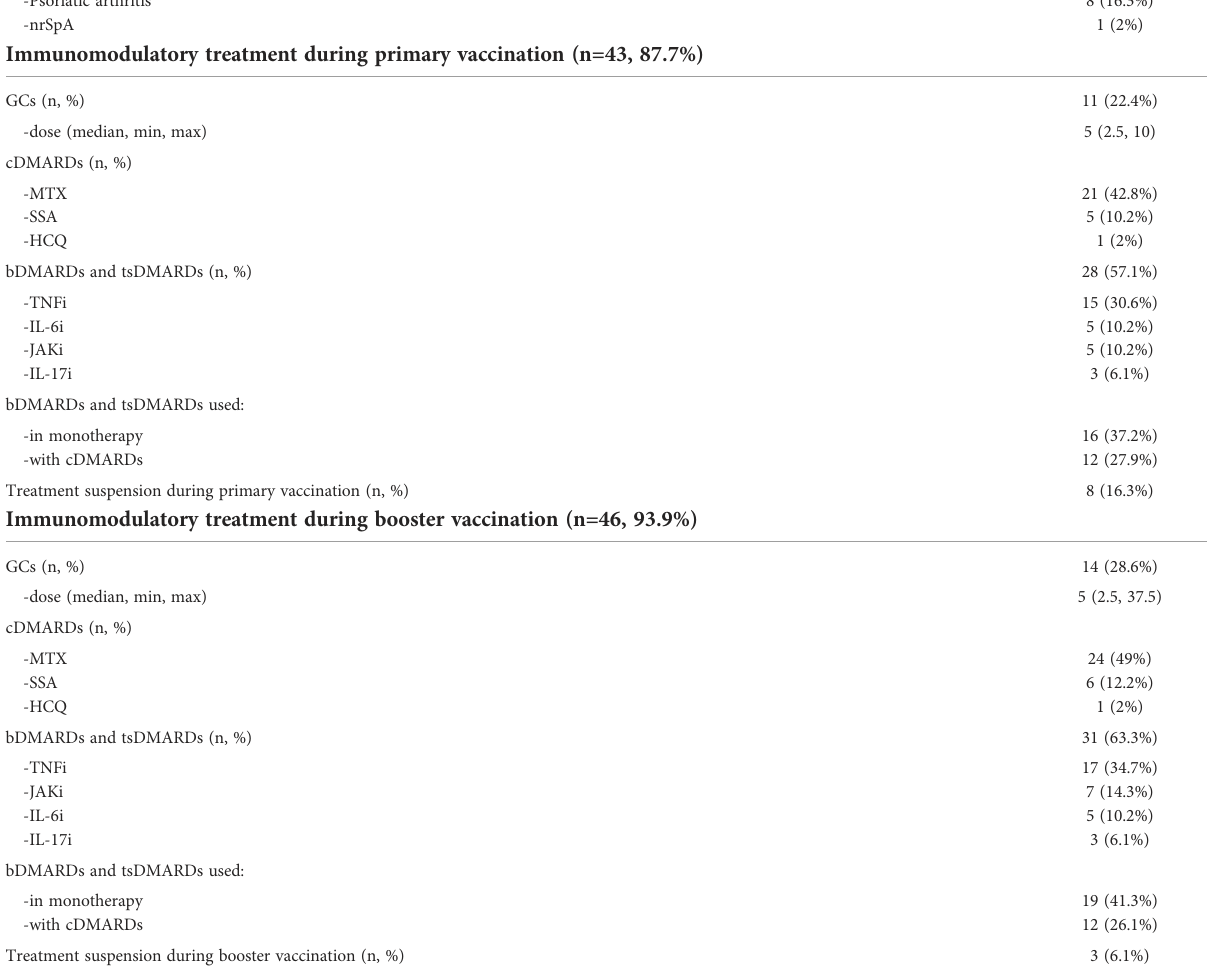
TABLE 2 In fl ammatory arthritis group